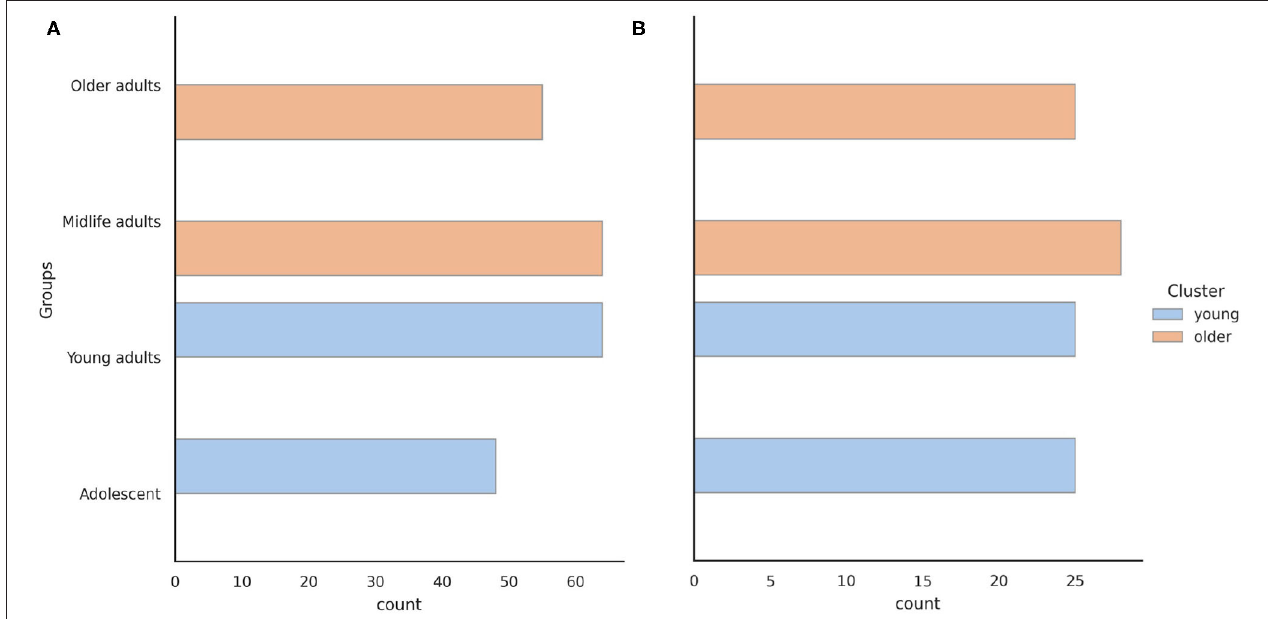
FIGURE 1 | Age distribution of the (A) psychophysiological outcomes of brain atrophy and (B) stroop switching card test datasets.